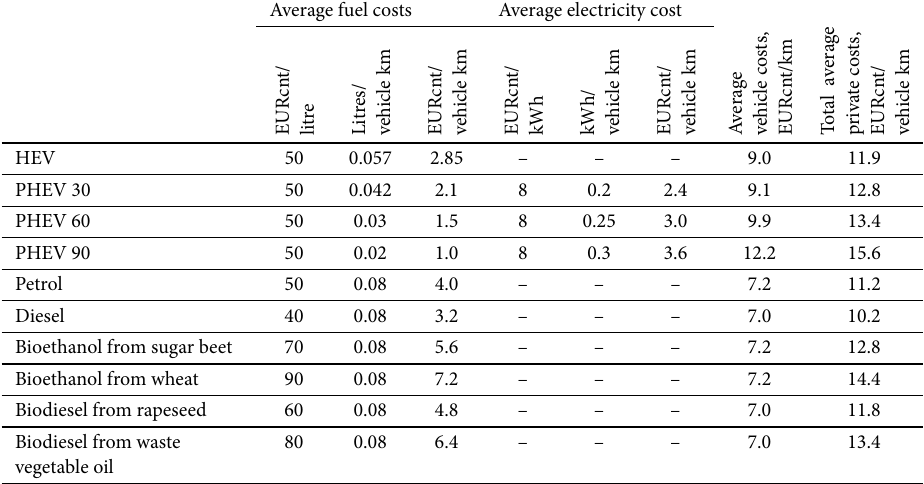
Table 7. Private costs of motor vehicle in 2020, EURcnt/kWh